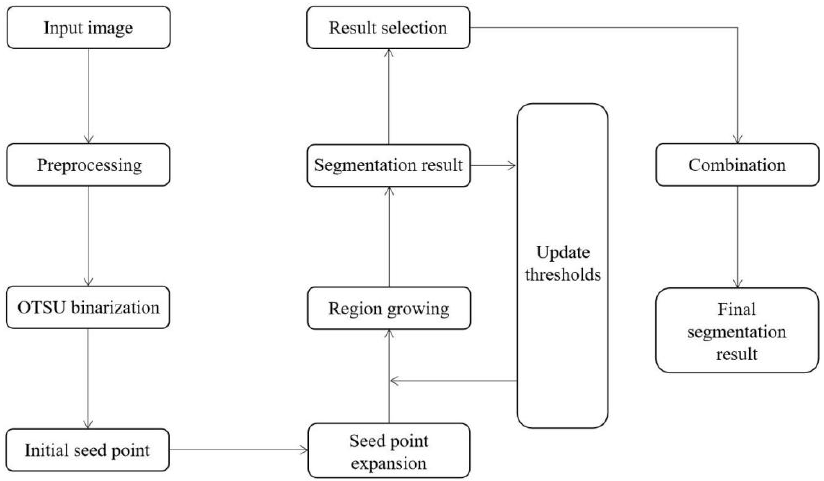
Figure 3. Workflow diagram of our proposed method.